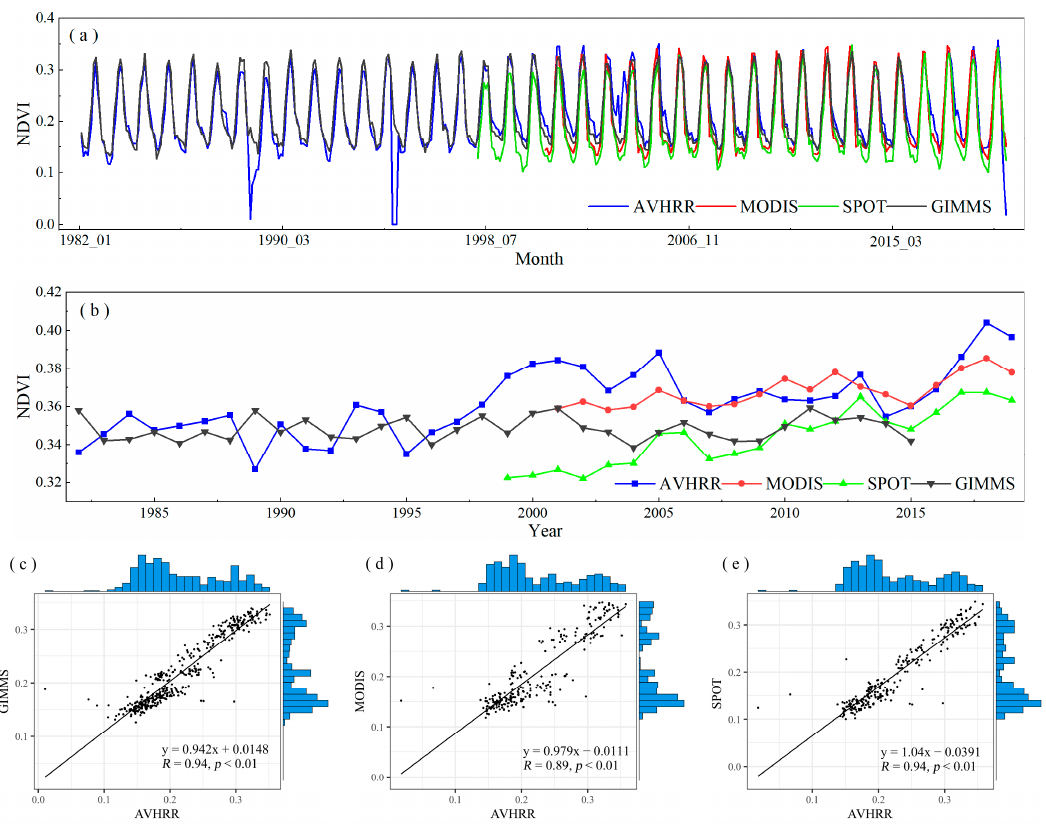
Figure 3. Comparison of monthly and yearly scale time series of AVHRR NDVI, GIMMS NDVI, MODIS NDVI, and SPOT NDVI from 1982 to 2019 ( a , b ). Scatter-plot comparison of AVHRR NDVI with GIMMS NDVI ( c ), MODIS NDVI ( d ), and SPOT NDVI ( e ), respectively.